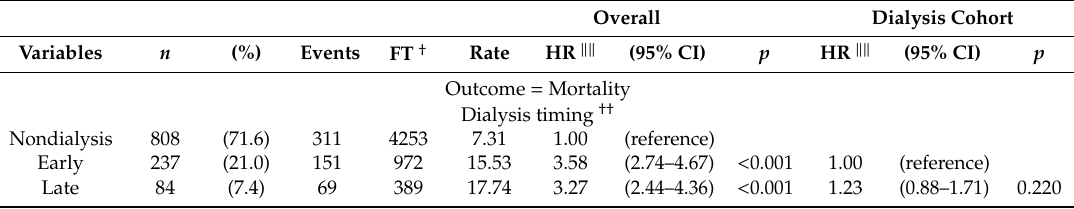
Table 3. Multivariate analysis of mortality among the early, late, and non-dialysis groups.